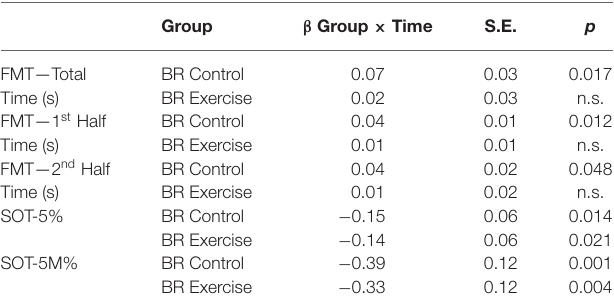
TABLE 5 | Significant interaction effects resulting from trend analysis of sensorimotor